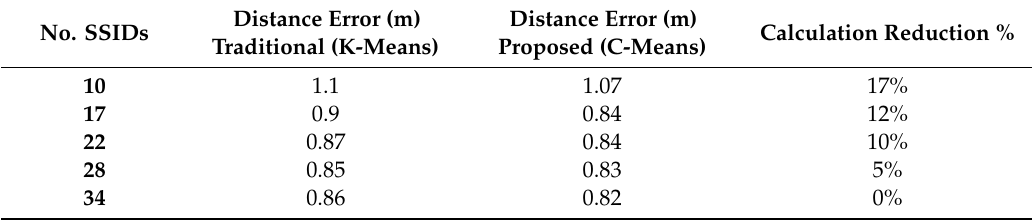
Table 7. The Calculation reduction of positioning process versus number of